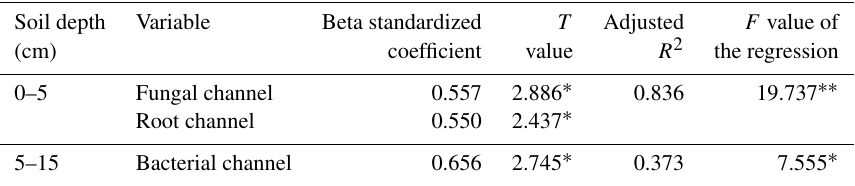
Table 3. Relations between modelled mineral N delivered by different energy channels and soybean yield based on multiple linear regression analysis. Data were min–max normalized and are dimensionless.